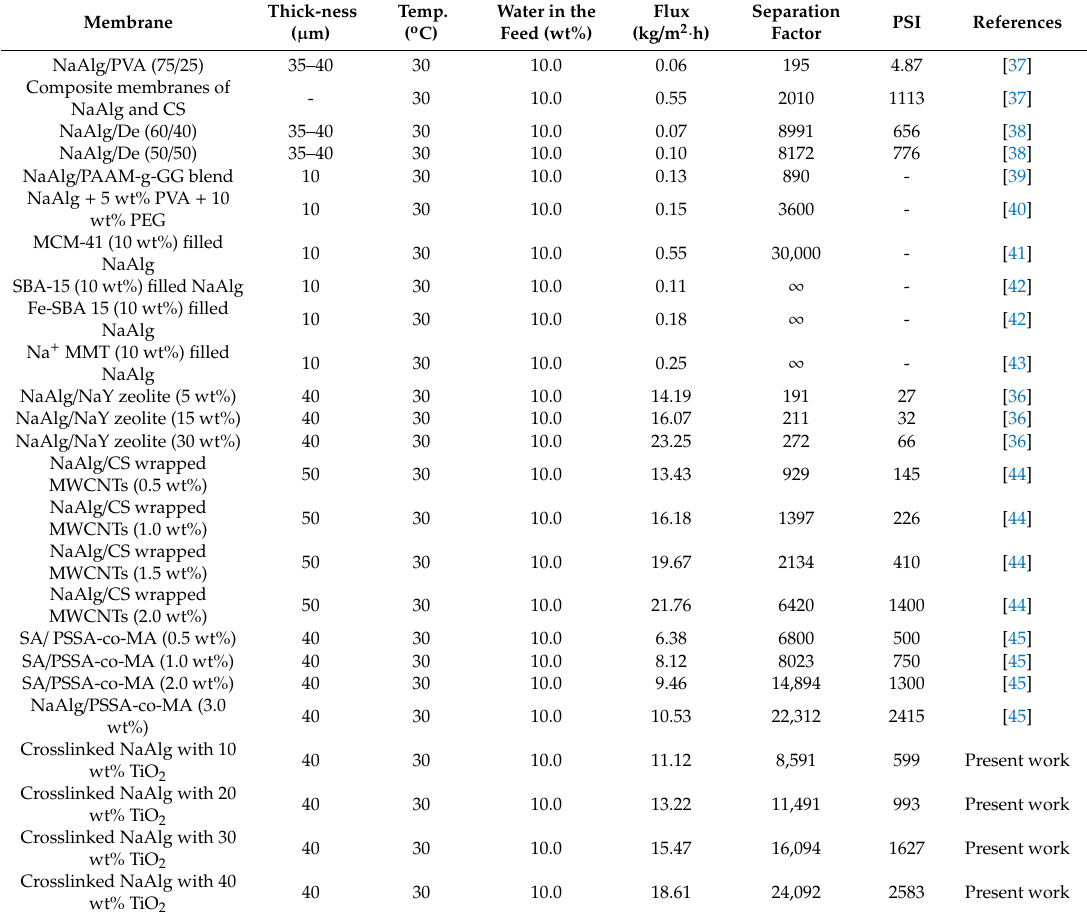
Table 2. Comparative study of pervaporation performance of sodium alginate-based membranes reported in literature for the dehydration of